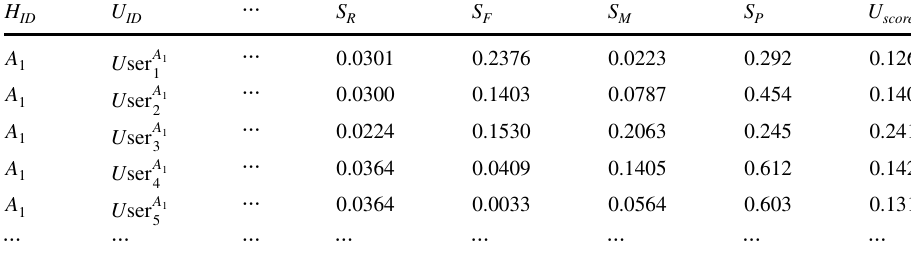
Table 8 Opinion leader